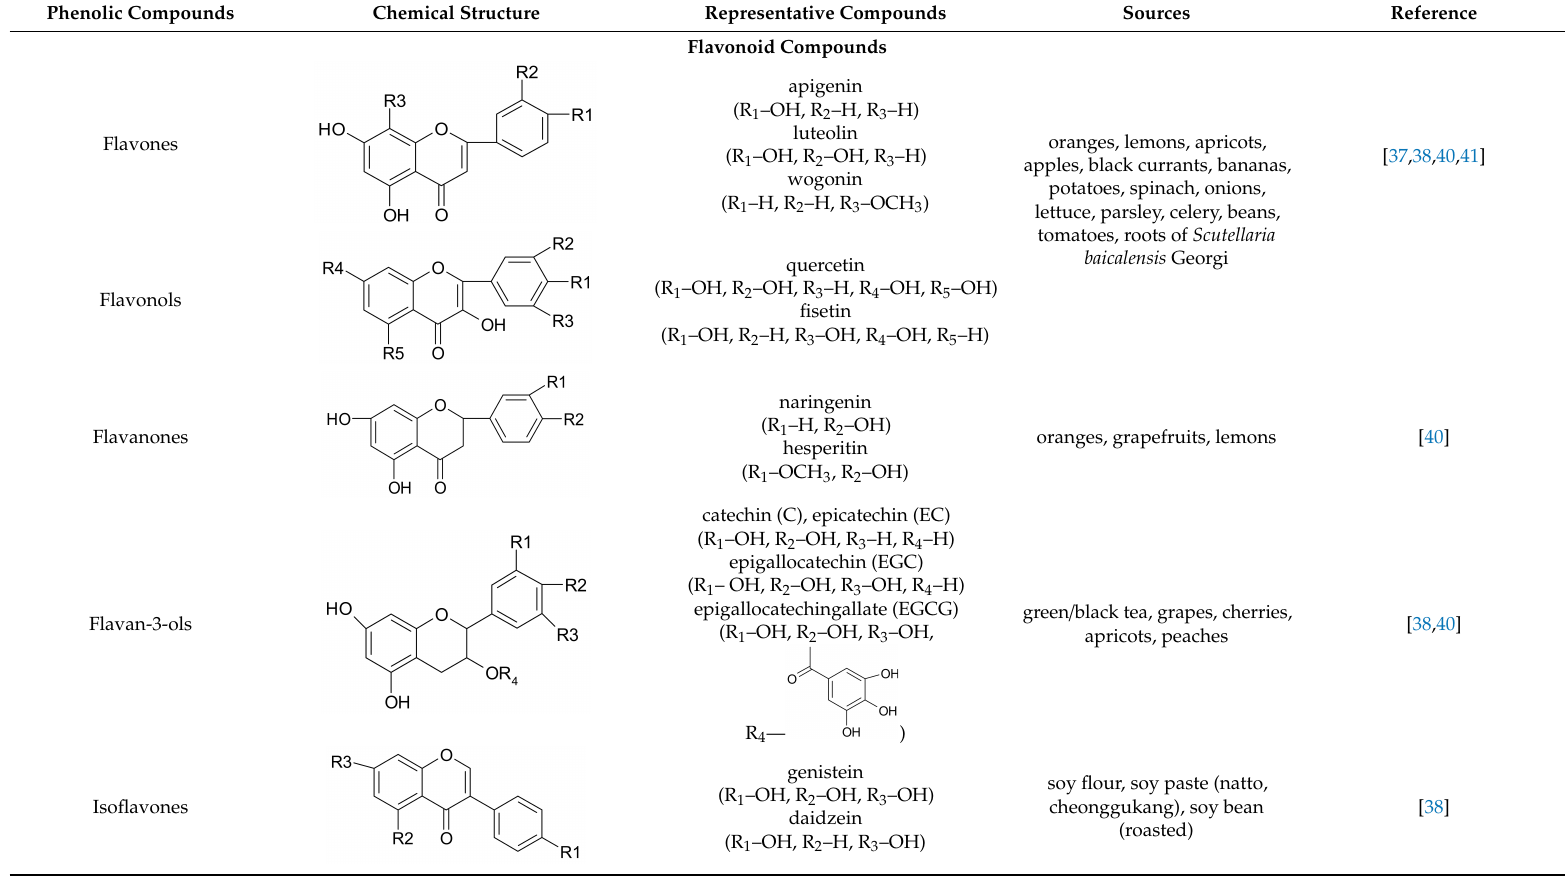
Table 1. Main classes of phenolic compounds with representative members and sources, frequently investigated for overcoming MDR in